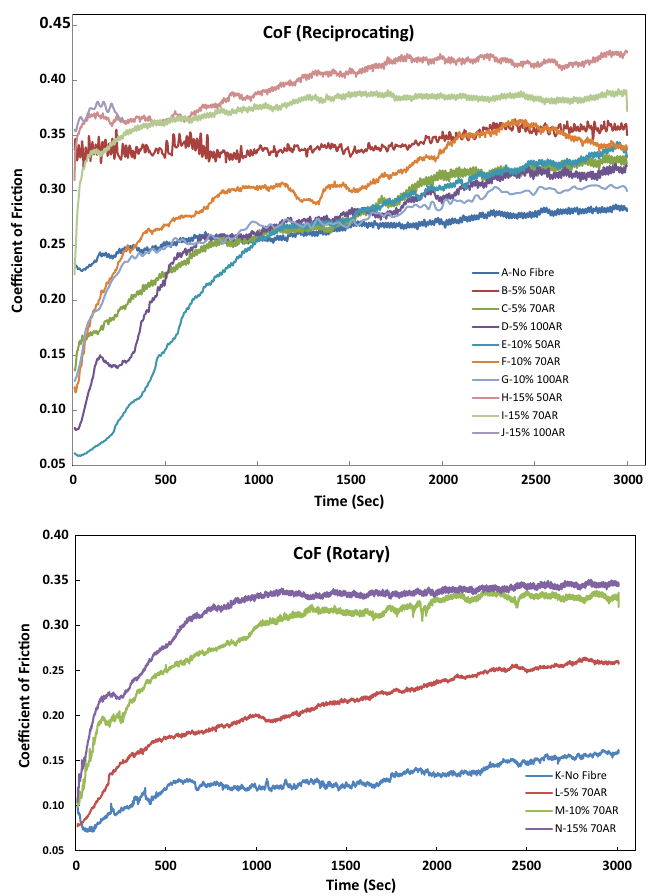
Figure 2. Transient and steady-state coefficient of friction vs. time for ( a ) reciprocating and ( b ) rotary